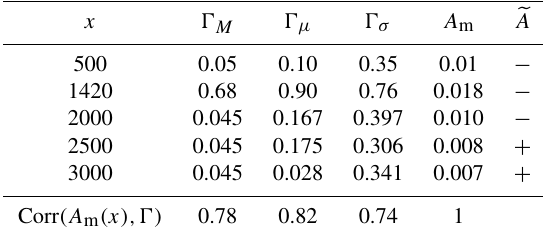
Table 2. Measure of the local coherence of the normal sea condition wave.